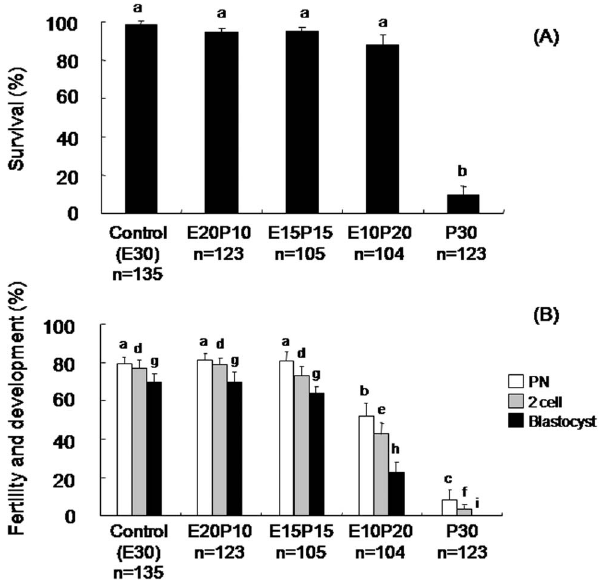
Figure 2. The effects of COOH-PLL on survival, fertility and developmental ability of vitrified mouse oocytes after IVF. Data are shown as means 6 S.E.M. Different superscripts denote a significant difference (P , 0.05). Numbers of oocytes used in each group were described under the treatment group.